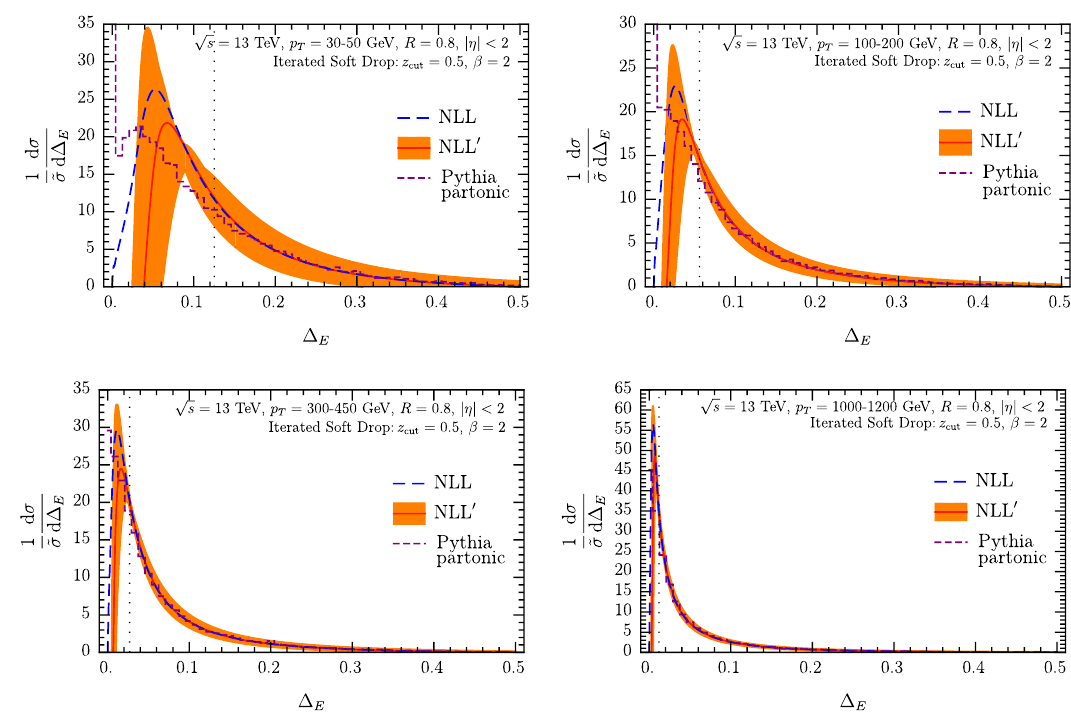
Figure 6 . Jet energy drop distribution with z cut = 0 . 5 and β = 2 at NLL (dashed blue) and NLL 0 accuracy (orange curve and band), compared to Pythia (dashed purple). The different panels correspond to different jet transverse momenta. The central curves are normalized to unity between the dotted vertical line and the endpoint ∆ E = z cut .